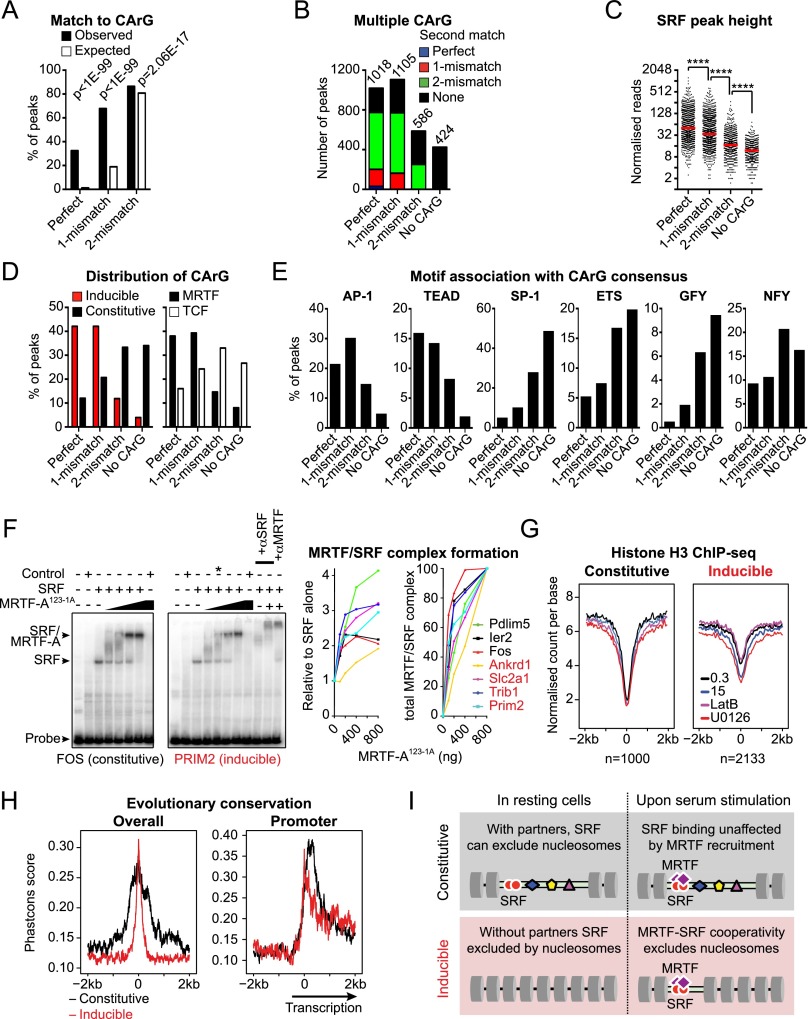
Characterization of MRTF- and TCF-associated SRF sites. (A) Match to the SRF CArG consensus (CCW6GG) within 100 bp of the SRF peak summit. Expected values are number of matches expected by chance with randomly selected sequences. (B) Multiple matches to the CArG consensus exist within 100 bp of each SRF peak summit. Peaks are grouped according to the best CArG match. (C) SRF peak height increases with matches to the CArG consensus. P < 0.0001, Mann-Whitney test. (D) Relationships between CArG consensus match and SRF-binding inducibility (left) or cofactor specificity (right). (E) SRF-associated sequence motif frequency plotted as function of match to the CArG consensus. (F) MRTF–SRF complex-binding properties at constitutive and inducible sites are similar in EMSA. (Left) EMSA analysis performed with whole-cell extract from NIH3T3 cells transfected with SRF expression plasmid (SRF) or vector alone (control) together with recombinant MRTF-A123-1A (non-actin-binding mutant) (Vartiainen et al. 2007). An asterisk marks the binding conditions used for antibody supershift assays (αSRF and αMRTF). (Right) Yield of the total MRTF–SRF complex quantified relative to SRF alone, taken as 1 (left plot) or percentage of maximum (right panel). Inducible and constitutive SRF sites are coded red and black, respectively. (G) H3 ChIP-seq metaprofiles at constitutive and inducible SRF sites under different assay conditions. (H) Evolutionary conservation across SRF-binding sites, determined by the Phastcons algorithm. (Left) All sites. (Right) Promoter-associated sites (transcription at the right). (I) Indirect cooperativity model for inducible SRF binding. Constitutive SRF binding and low nucleosome occupancy are facilitated by low nucleosome affinity and/or binding of other transcription factors nearby, and MRTF activation therefore has no effect. Inducible SRF binding is associated with high nucleosome affinity and/or the absence of other transcription factor-binding events; at these sites, SRF binding alone is insufficient for nucleosome displacement, which requires formation of the MRTF/SRF complex.